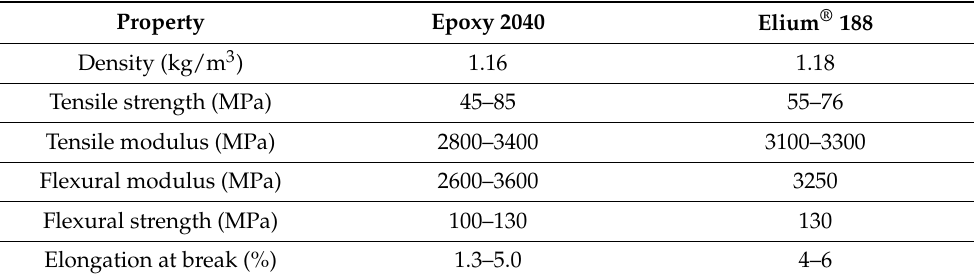
Table 3. The mechanical properties of resins being used.